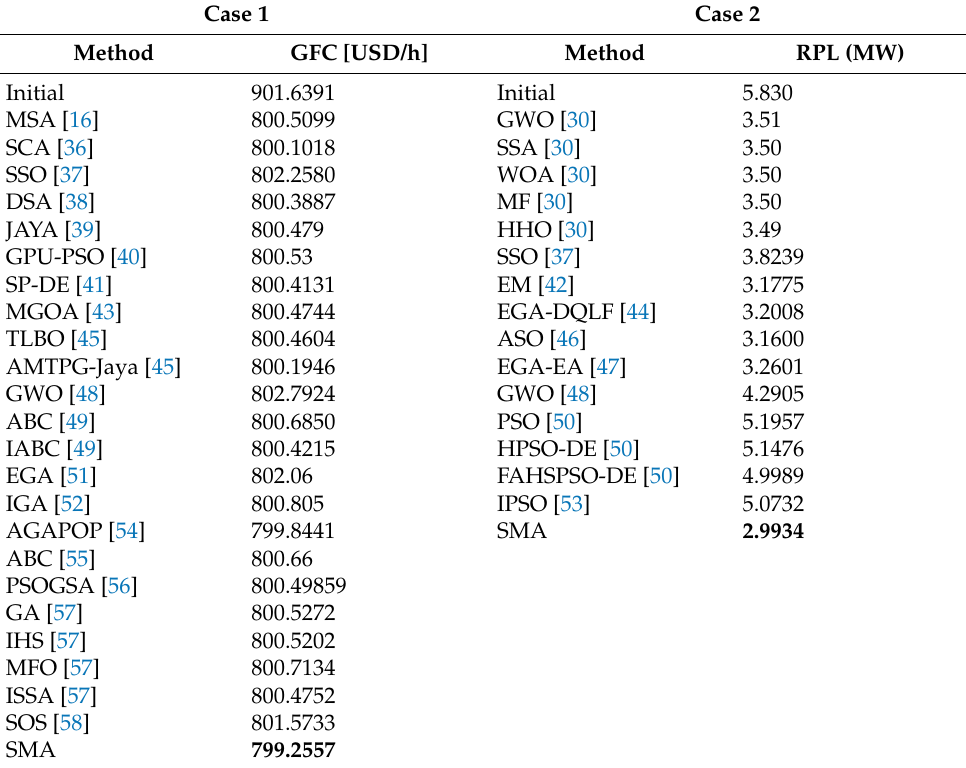
Table 4. Comparison of the results obtained by the SMA with other methods for Cases (1 and 2). Case 1